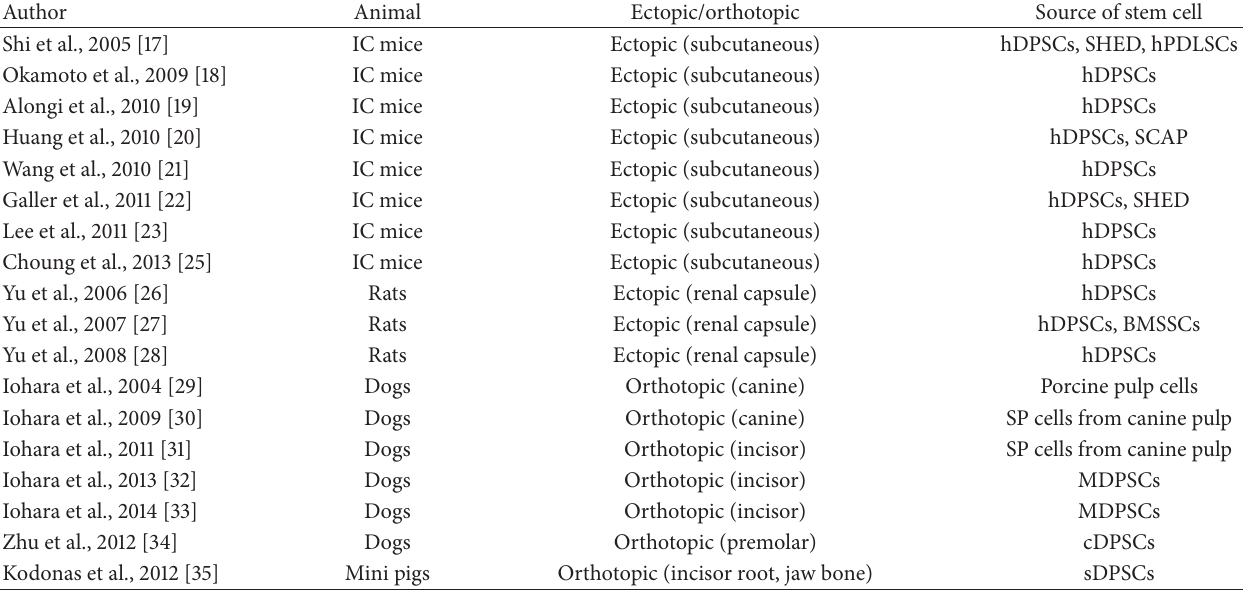
Table 1: Description of in vivo experiments with the application of DPSCs for pulp-dentin complex